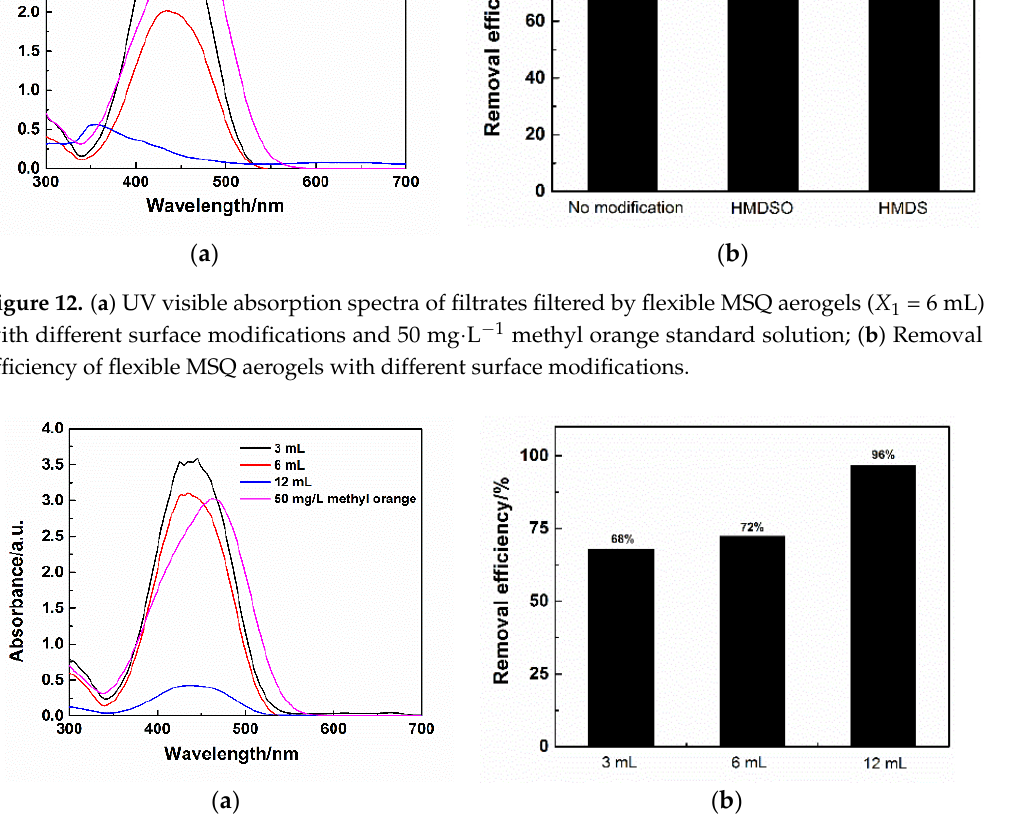
Figure 14. ( a ) Digital camera image of different dye solutions before and after absorption of flexible MSQ aerogel with HMDS surface modification; ( b ) UV visible absorption spectra of Congo Red filtrates filtered by flexible MSQ aerogels with HMDS surface modification.